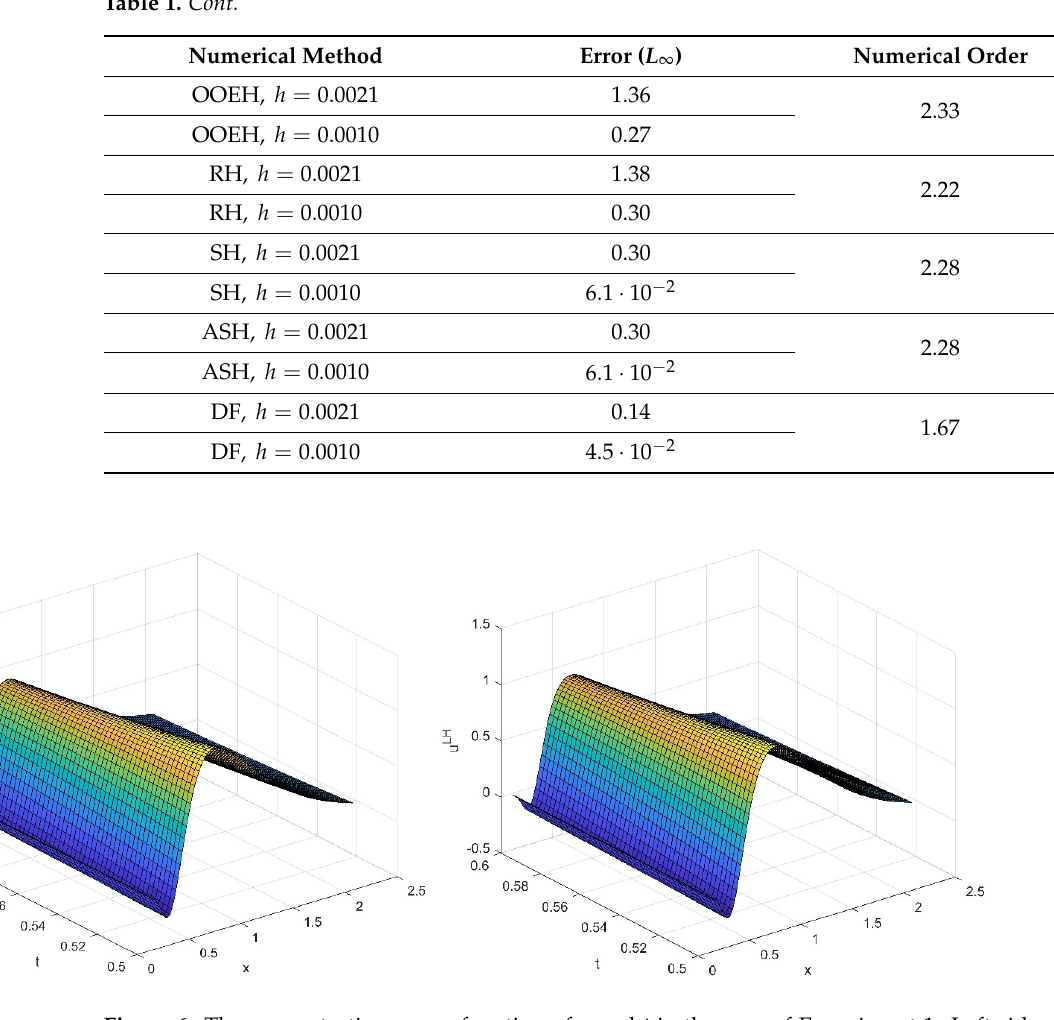
Table 2. Errors and numerical order of different algorithms for Experiment